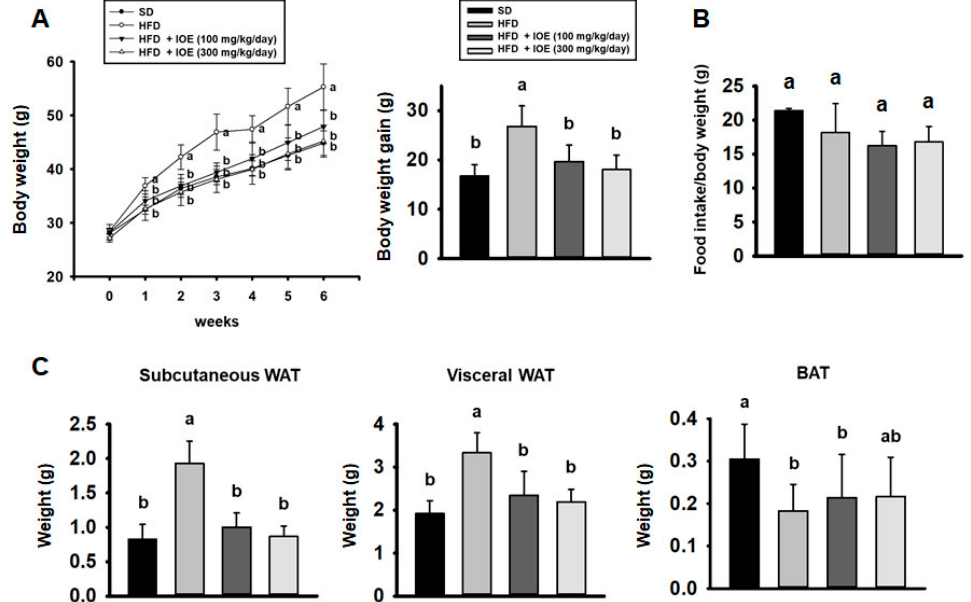
Figure 2. IOE reduces the adiposity of HFD-induced obese mice. Body mass gain ( A ), and food intake per unit body mass ( B ), measured during 6 weeks’ treatment with or without IOE. ( C ) Subcutaneous and visceral WAT mass. Data are expressed as mean ± S.D ( n = 6). Values with different letters are significantly different; p < 0.05 (a > b). Table 2. Effect of IOE administration on blood parameters in mice that were HFD-fed for 6 weeks.